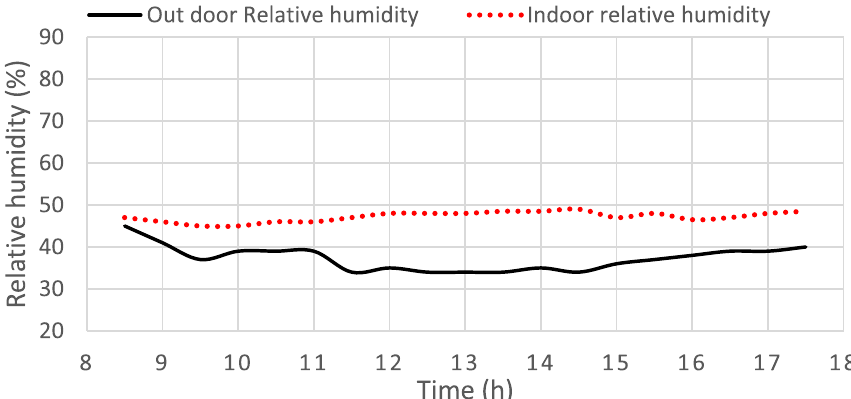
Fig. 11 Variation of outdoor and indoor relative humidity with time for day 2